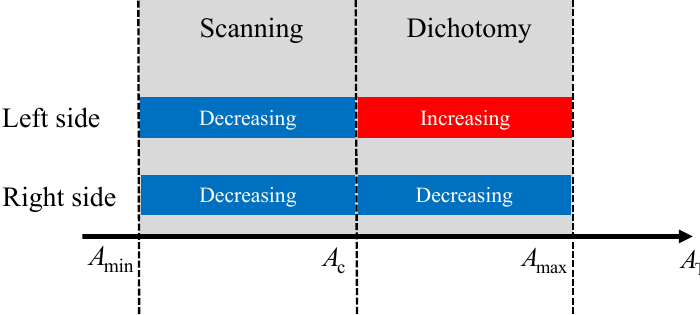
Figure 9. The process of solving Equation (24) by discrete scanning